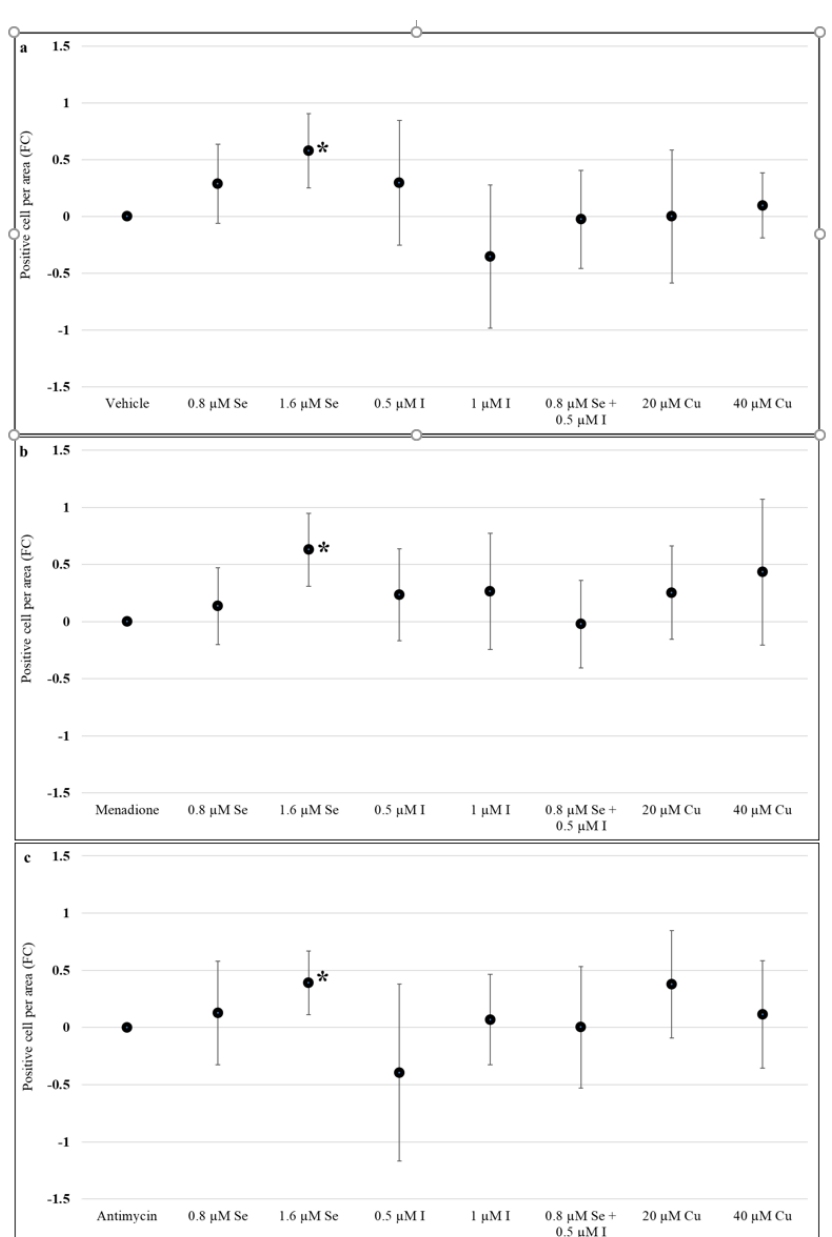
Figure 3. Effect of selenium, iodine, and copper supplementation on proliferation in first trimester placental explants. Placenta explants from 7 to 12 weeks of gestation ( n = 12) were cultured for 48 h for syncytial regeneration followed by supplementation with sodium selenite (0, 0.8, or 1.6 µ M), potassium iodide (0, 0.5, or 1 µ M), combination of sodium selenite and potassium iodide (0.8 µ M sodium selenite and 0.5 µ M potassium iodide), or copper (II) sulfate (0, 20, or 40 µ M) for 72 h with supplementation replenished every 24 h. ( a ) Placental explants were harvested following 72 h of supplementation and proliferation assessed by immunolabelling for Ki67. In addition, after 72 h supplementation, placental explants were treated with ( b ) 120 µ M menadione or ( c ) 480 µ M antimycin for 24 h to induce oxidative stress and then assessed for proliferation. Eight randomly selected regions per explant were used for quantification and statistical analyses. Data presented as a fold change (FC) relative to control ± standard error. Statistical significance was assessed using Generalised Estimating Equations with independence correlation structure with log 2-transformed positive stain per area to estimate fold change compared to controls followed by pre-specified post-hoc Bonferroni adjusted comparisons. * Indicates statistically different ( p < 0.05) from vehicle control